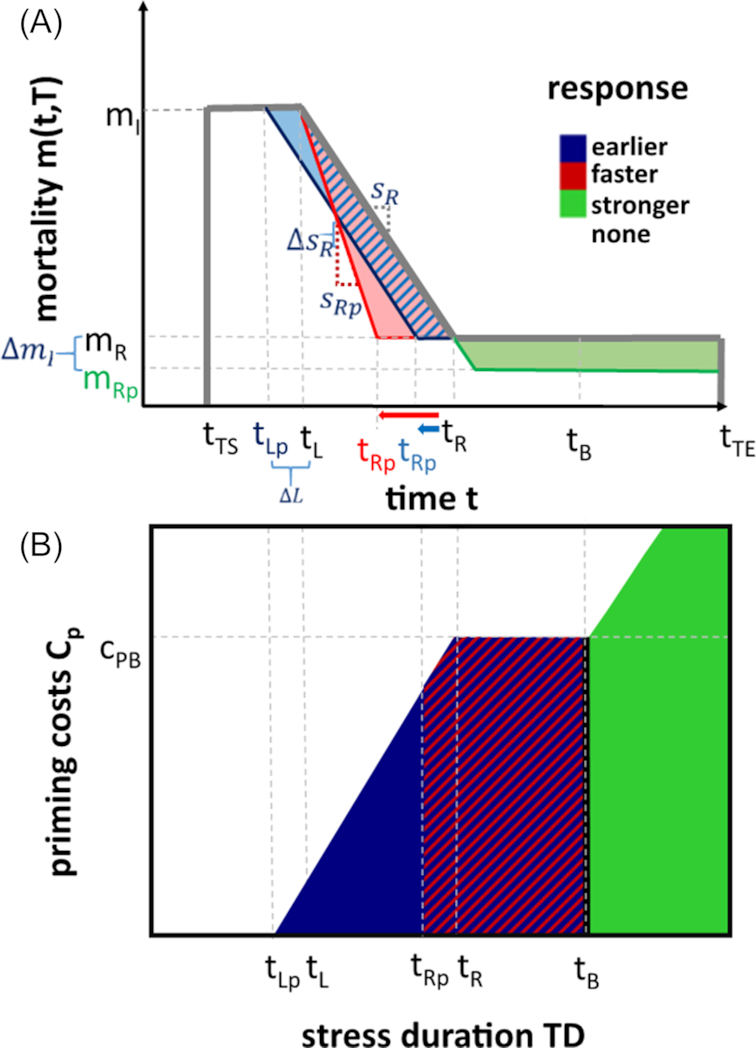
(A) Mortality reduction of the three strategies and (B) analytically determined parameter space favoring the different primed stress responses under exponential growth depending on stress duration and priming costs. Abbreviations: \documentclass[12pt]{minimal}
\usepackage{amsmath}
\usepackage{wasysym}
\usepackage{amsfonts}
\usepackage{amssymb}
\usepackage{amsbsy}
\usepackage{upgreek}
\usepackage{mathrsfs}
\setlength{\oddsidemargin}{-69pt}
\begin{document}
}{}${c_{\mathrm{ PB}}}$\end{document} = (baseline) priming costs for which the three responses grant a benefit equal to the naïve response; \documentclass[12pt]{minimal}
\usepackage{amsmath}
\usepackage{wasysym}
\usepackage{amsfonts}
\usepackage{amssymb}
\usepackage{amsbsy}
\usepackage{upgreek}
\usepackage{mathrsfs}
\setlength{\oddsidemargin}{-69pt}
\begin{document}
}{}${m_\mathrm{ I}}$\end{document} = initial mortality; \documentclass[12pt]{minimal}
\usepackage{amsmath}
\usepackage{wasysym}
\usepackage{amsfonts}
\usepackage{amssymb}
\usepackage{amsbsy}
\usepackage{upgreek}
\usepackage{mathrsfs}
\setlength{\oddsidemargin}{-69pt}
\begin{document}
}{}${m_\mathrm{ R}}$\end{document} = final mortality level of the stress response; \documentclass[12pt]{minimal}
\usepackage{amsmath}
\usepackage{wasysym}
\usepackage{amsfonts}
\usepackage{amssymb}
\usepackage{amsbsy}
\usepackage{upgreek}
\usepackage{mathrsfs}
\setlength{\oddsidemargin}{-69pt}
\begin{document}
}{}${m_{\mathrm{ Rp}}}$\end{document} = primed (reduced) \documentclass[12pt]{minimal}
\usepackage{amsmath}
\usepackage{wasysym}
\usepackage{amsfonts}
\usepackage{amssymb}
\usepackage{amsbsy}
\usepackage{upgreek}
\usepackage{mathrsfs}
\setlength{\oddsidemargin}{-69pt}
\begin{document}
}{}${m_\mathrm{ R}}$\end{document} (stronger response); \documentclass[12pt]{minimal}
\usepackage{amsmath}
\usepackage{wasysym}
\usepackage{amsfonts}
\usepackage{amssymb}
\usepackage{amsbsy}
\usepackage{upgreek}
\usepackage{mathrsfs}
\setlength{\oddsidemargin}{-69pt}
\begin{document}
}{}${t_{\mathrm{ TS}}}$\end{document} = beginning of the triggering stress; \documentclass[12pt]{minimal}
\usepackage{amsmath}
\usepackage{wasysym}
\usepackage{amsfonts}
\usepackage{amssymb}
\usepackage{amsbsy}
\usepackage{upgreek}
\usepackage{mathrsfs}
\setlength{\oddsidemargin}{-69pt}
\begin{document}
}{}${t_\mathrm{ L}}$\end{document} = end of the response lag phase; \documentclass[12pt]{minimal}
\usepackage{amsmath}
\usepackage{wasysym}
\usepackage{amsfonts}
\usepackage{amssymb}
\usepackage{amsbsy}
\usepackage{upgreek}
\usepackage{mathrsfs}
\setlength{\oddsidemargin}{-69pt}
\begin{document}
}{}${t_{\mathrm{ Lp}}}$\end{document} = end of the primed (shorter) response lag phase (earlier response); \documentclass[12pt]{minimal}
\usepackage{amsmath}
\usepackage{wasysym}
\usepackage{amsfonts}
\usepackage{amssymb}
\usepackage{amsbsy}
\usepackage{upgreek}
\usepackage{mathrsfs}
\setlength{\oddsidemargin}{-69pt}
\begin{document}
}{}${t_\mathrm{ R}}$\end{document} = time point when \documentclass[12pt]{minimal}
\usepackage{amsmath}
\usepackage{wasysym}
\usepackage{amsfonts}
\usepackage{amssymb}
\usepackage{amsbsy}
\usepackage{upgreek}
\usepackage{mathrsfs}
\setlength{\oddsidemargin}{-69pt}
\begin{document}
}{}${m_\mathrm{ R}}$\end{document} has been reached; \documentclass[12pt]{minimal}
\usepackage{amsmath}
\usepackage{wasysym}
\usepackage{amsfonts}
\usepackage{amssymb}
\usepackage{amsbsy}
\usepackage{upgreek}
\usepackage{mathrsfs}
\setlength{\oddsidemargin}{-69pt}
\begin{document}
}{}${t_{\mathrm{ Rp}}}$\end{document} = time point when \documentclass[12pt]{minimal}
\usepackage{amsmath}
\usepackage{wasysym}
\usepackage{amsfonts}
\usepackage{amssymb}
\usepackage{amsbsy}
\usepackage{upgreek}
\usepackage{mathrsfs}
\setlength{\oddsidemargin}{-69pt}
\begin{document}
}{}${m_\mathrm{ R}}$\end{document} has been reached with an earlier or faster stress response; \documentclass[12pt]{minimal}
\usepackage{amsmath}
\usepackage{wasysym}
\usepackage{amsfonts}
\usepackage{amssymb}
\usepackage{amsbsy}
\usepackage{upgreek}
\usepackage{mathrsfs}
\setlength{\oddsidemargin}{-69pt}
\begin{document}
}{}${t_\mathrm{ B}}$\end{document} = (baseline) stress duration when the three responses grant a benefit equal to the naïve response; \documentclass[12pt]{minimal}
\usepackage{amsmath}
\usepackage{wasysym}
\usepackage{amsfonts}
\usepackage{amssymb}
\usepackage{amsbsy}
\usepackage{upgreek}
\usepackage{mathrsfs}
\setlength{\oddsidemargin}{-69pt}
\begin{document}
}{}${t_{\mathrm{ TE}}}$\end{document} = end of triggering stress; \documentclass[12pt]{minimal}
\usepackage{amsmath}
\usepackage{wasysym}
\usepackage{amsfonts}
\usepackage{amssymb}
\usepackage{amsbsy}
\usepackage{upgreek}
\usepackage{mathrsfs}
\setlength{\oddsidemargin}{-69pt}
\begin{document}
}{}${s_\mathrm{ R}}$\end{document} = slope of the mortality reduction; \documentclass[12pt]{minimal}
\usepackage{amsmath}
\usepackage{wasysym}
\usepackage{amsfonts}
\usepackage{amssymb}
\usepackage{amsbsy}
\usepackage{upgreek}
\usepackage{mathrsfs}
\setlength{\oddsidemargin}{-69pt}
\begin{document}
}{}${s_{\mathrm{ Rp}}}$\end{document} = primed (higher) slope of the mortality reduction (faster response)